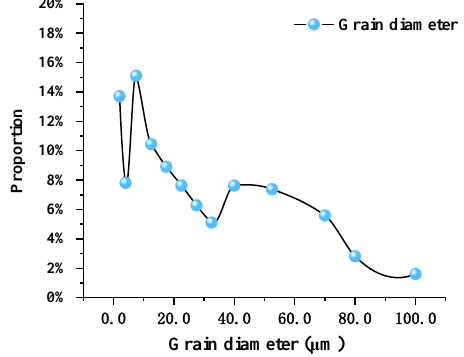
Figure 5. Particle microscope image ( a ) and discrete element particle image ( b ).